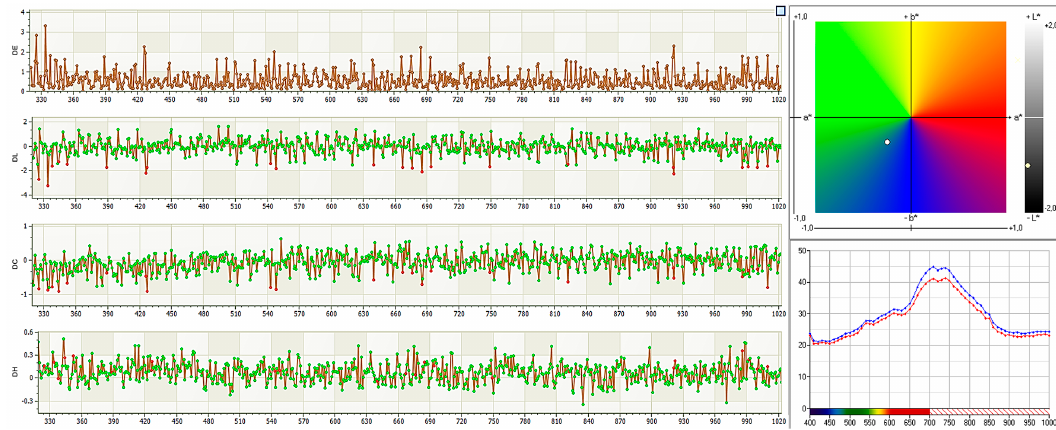
Figure 13. CMC(2:1) distances between the averaged value of spectral reflectance taken each k ∆ t (with k = 1 . . . 149).